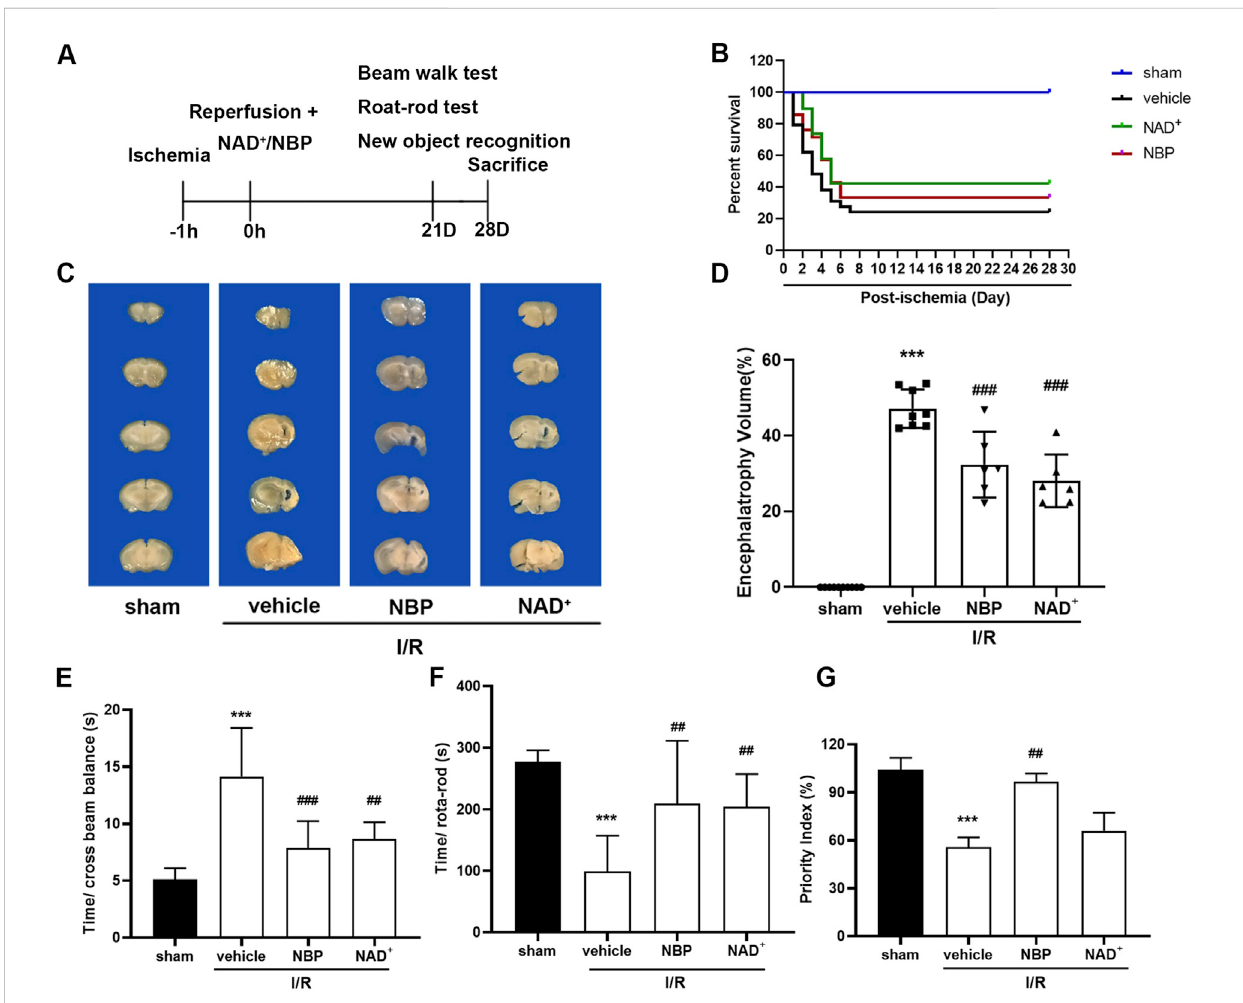
FIGURE 4 Effects of NAD + and NBP on long-term survival and neurological recovery after cerebral I/R in mice. (A) Mice were treated to behavioral tests at the third week after I/R, and brain samples were collected at the fourth week for pathological analysis. (B) Ratio of mice surviving at 28 days after I/R surgery. (C, D) After treatment with NAD + and NBP, brain atrophy of the ischemic hemisphere is decreased. NAD + and NBP reduced the brain atrophy of the ischemic hemisphere 28 days after I/R. The effects of NAD + and NBP on beam balance test (E) , rota-rod test (F) and new object recognition experiment (G) weredetectedatday21afterI/R. ***p < 0.001vs.sham, ## p < 0.01and ### p < 0.001vs.vehiclebyOne-wayanalysisofANOVAfollowedby Tukey ’ s multiple comparisons test. Data were expressed as the mean ± SD. There were at least six animals in each